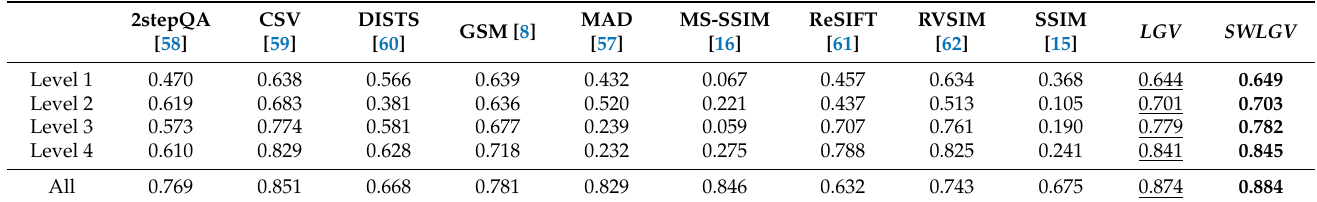
Table 6. Comparison of SROCC of each FR-IQA metrics on TID2008’s [56] distortion levels (Level 1 represents the lowest level of degradation, while Level 5 represents the highest one). The highest values are typed in bold , while the second highest ones are underlined.